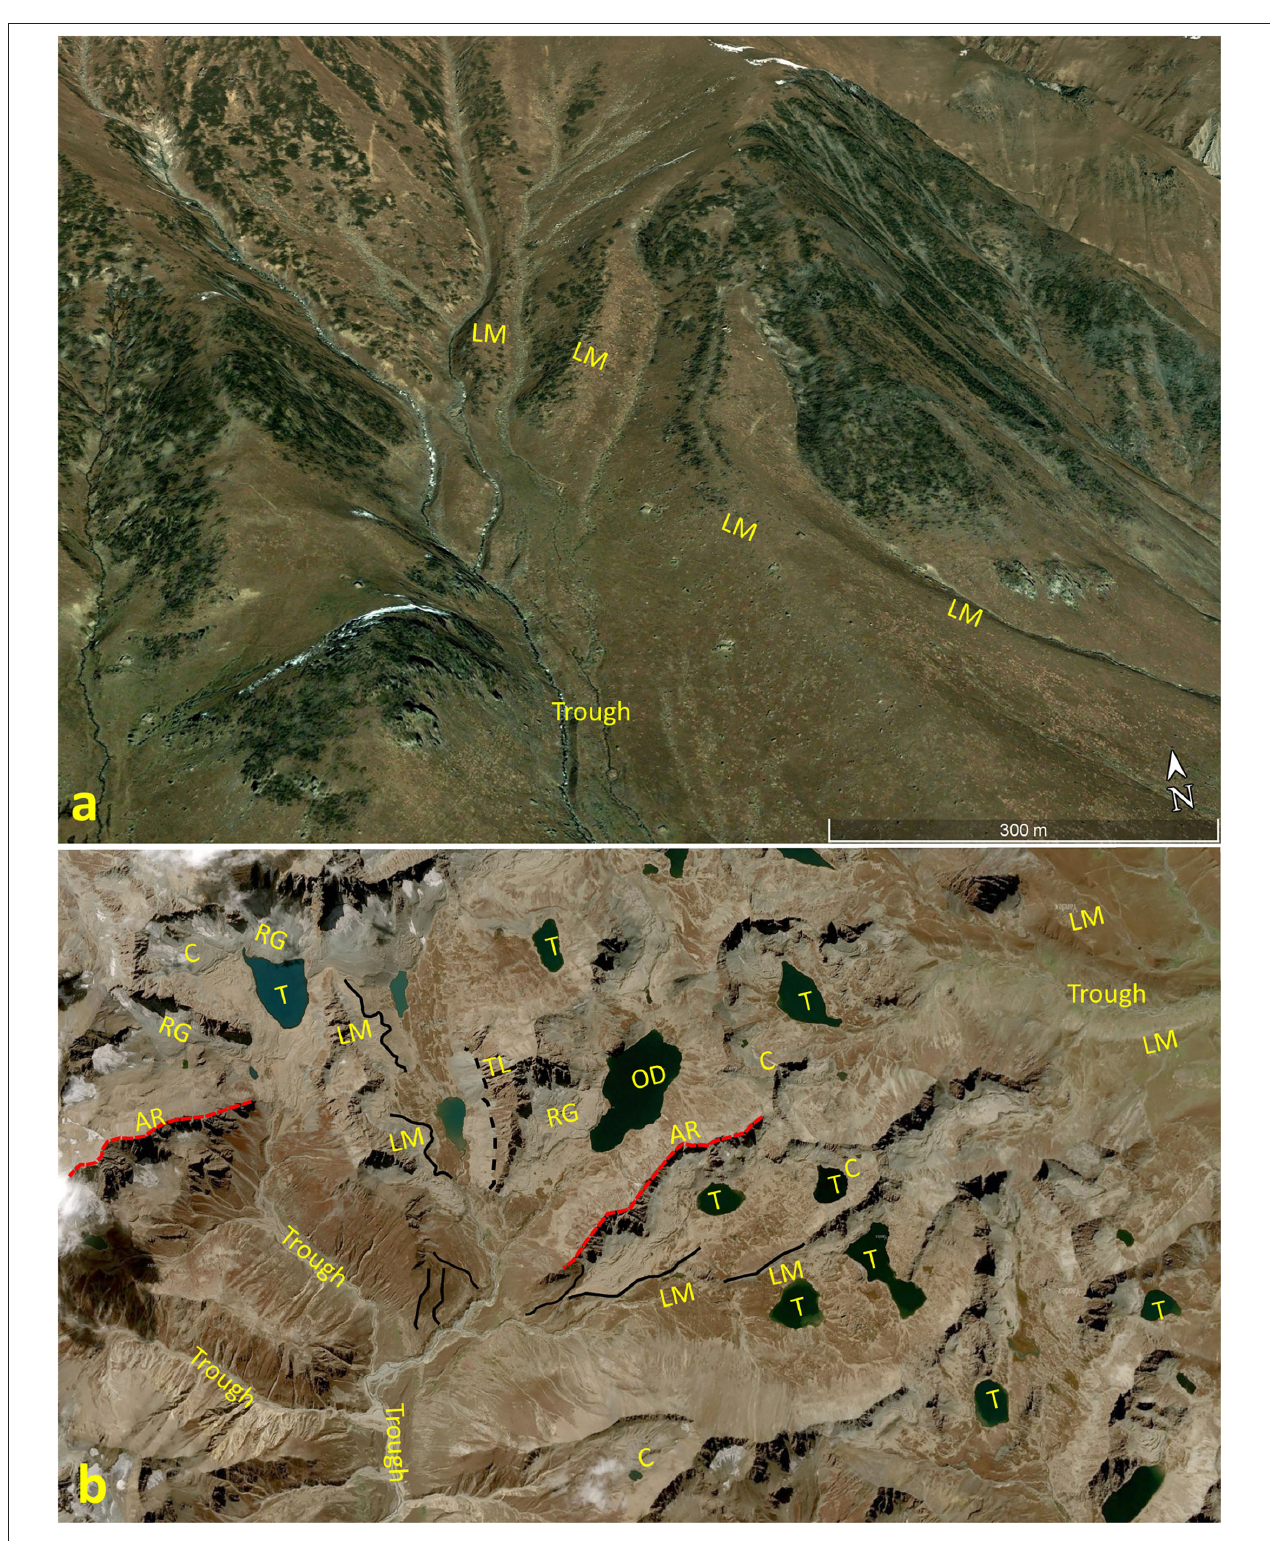
FIGURE 4 | Google Earth image (a) shows lateral moraines (LM) of different glacial stages (4 stages) and the glacial trough, (b) shows the glacial sculptured landscape. Some of the prominent features are labeled are cirques (C), rock glacier (RG), tarn (T), overdeepening (OD), lateral moraines (LM), arete ridges (AR), trim line (TL), glacial